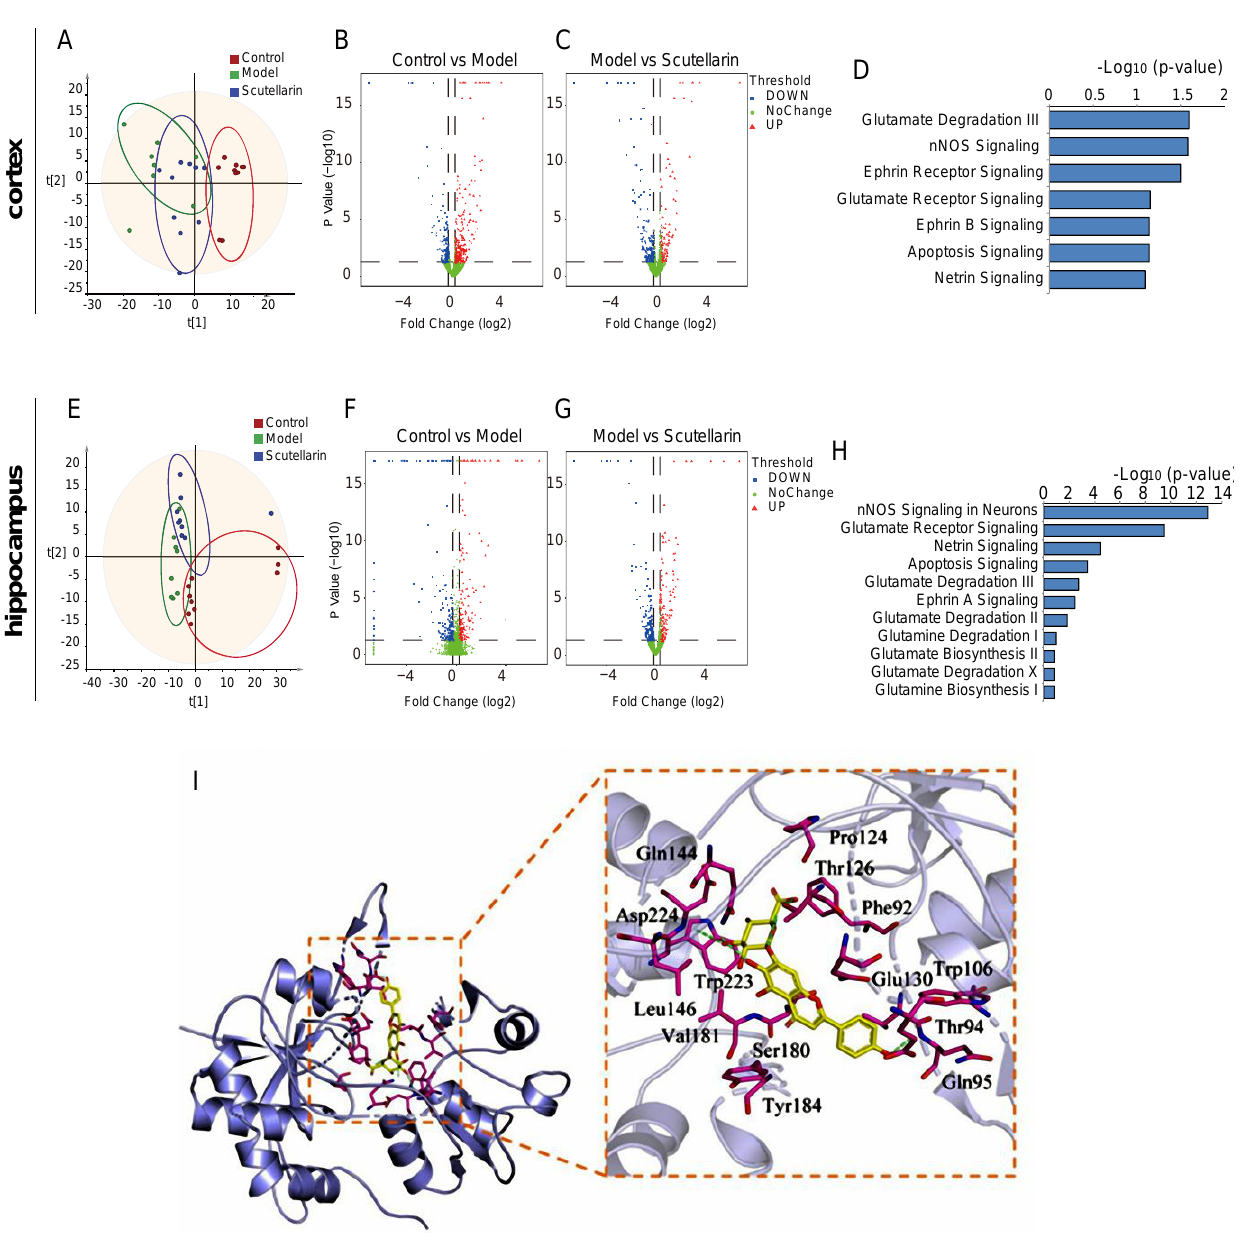
Figure 2. Scutellarin’s regulation of biological processes in the brains of MCAO/R model rats at 12 h after reperfusion. ( A , E ) PCA results of proteomics data showing the redressing effect of scutellarin on aberrant protein expression in the cortex ( A ) and hippocampus ( E ), which are induced by MCAO/R modeling. ( B , C , F , G ) Volcano plots showing the differential proteins between the groups that were screened for further biological pathway analysis. ( D , H ) IPA biological pathway enrichment results of cortex proteomics ( D ) and hippocampus proteomics ( H ). ( I ) Molecular docking results showing the interaction between scutellarin and GRIN1.